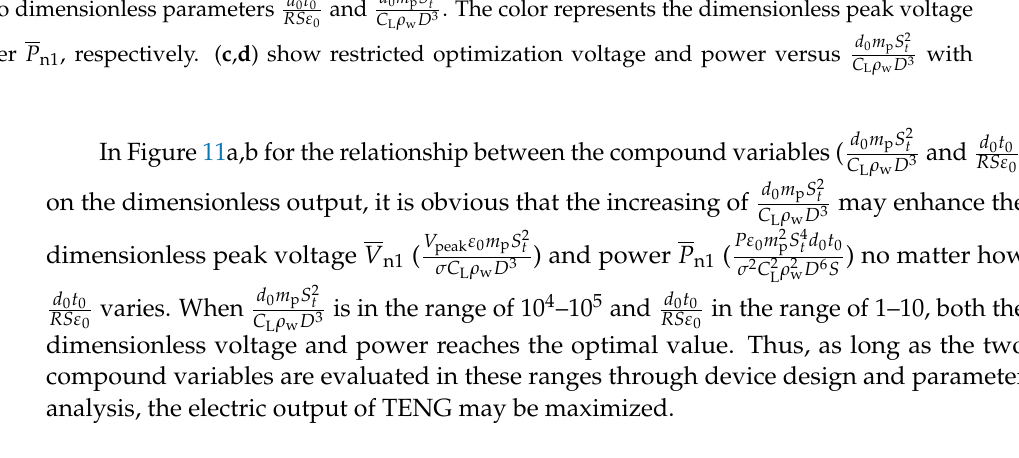
2 t and d 0 m p S . The color represents the dimensionless peak voltage RS ε 0 C L ρ w D 3